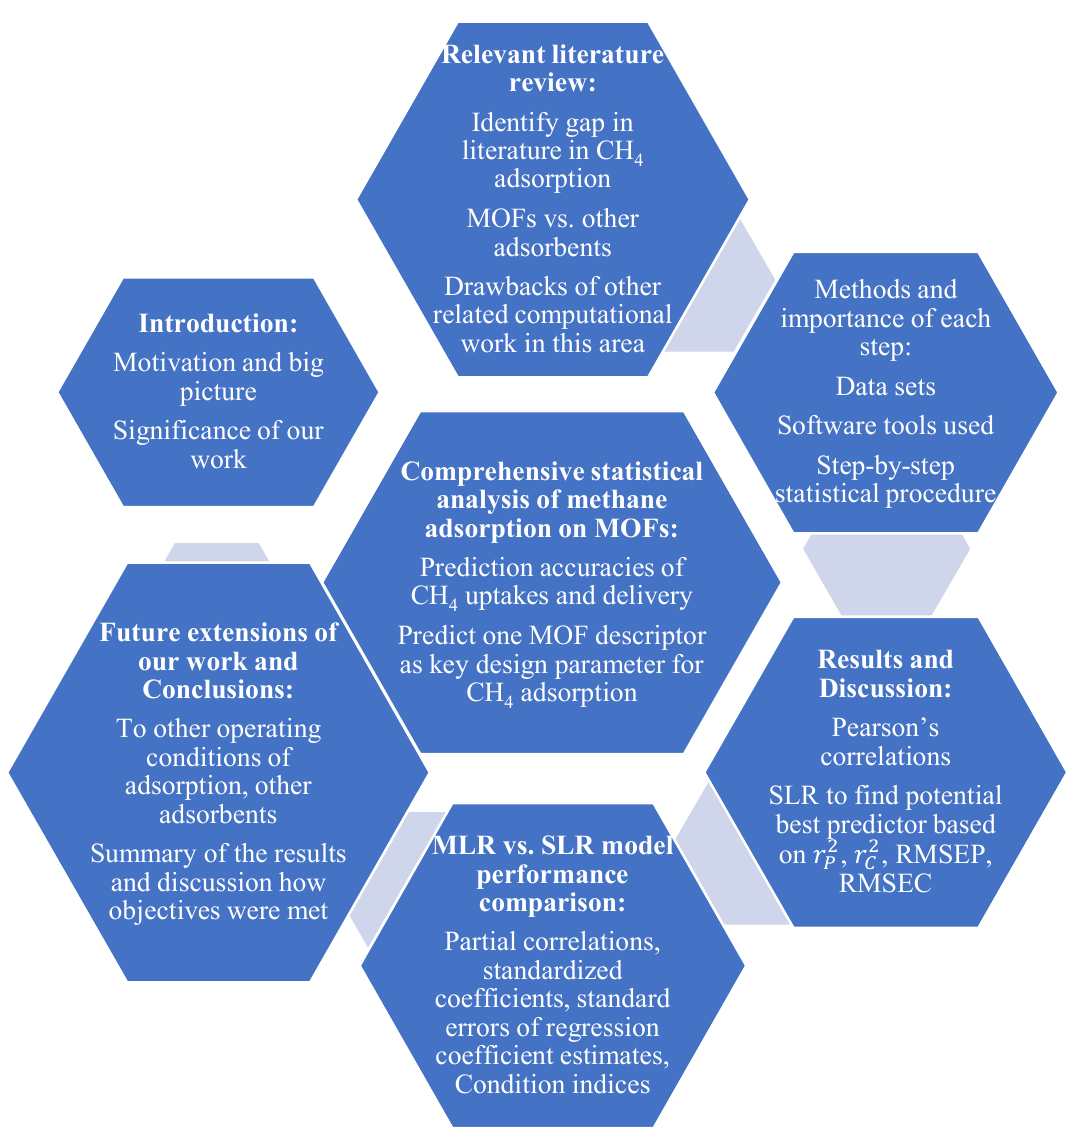
Figure 1 . Schematic of the flow of the main content in this work. Figure 1. Schematic of the flow of the main content in this